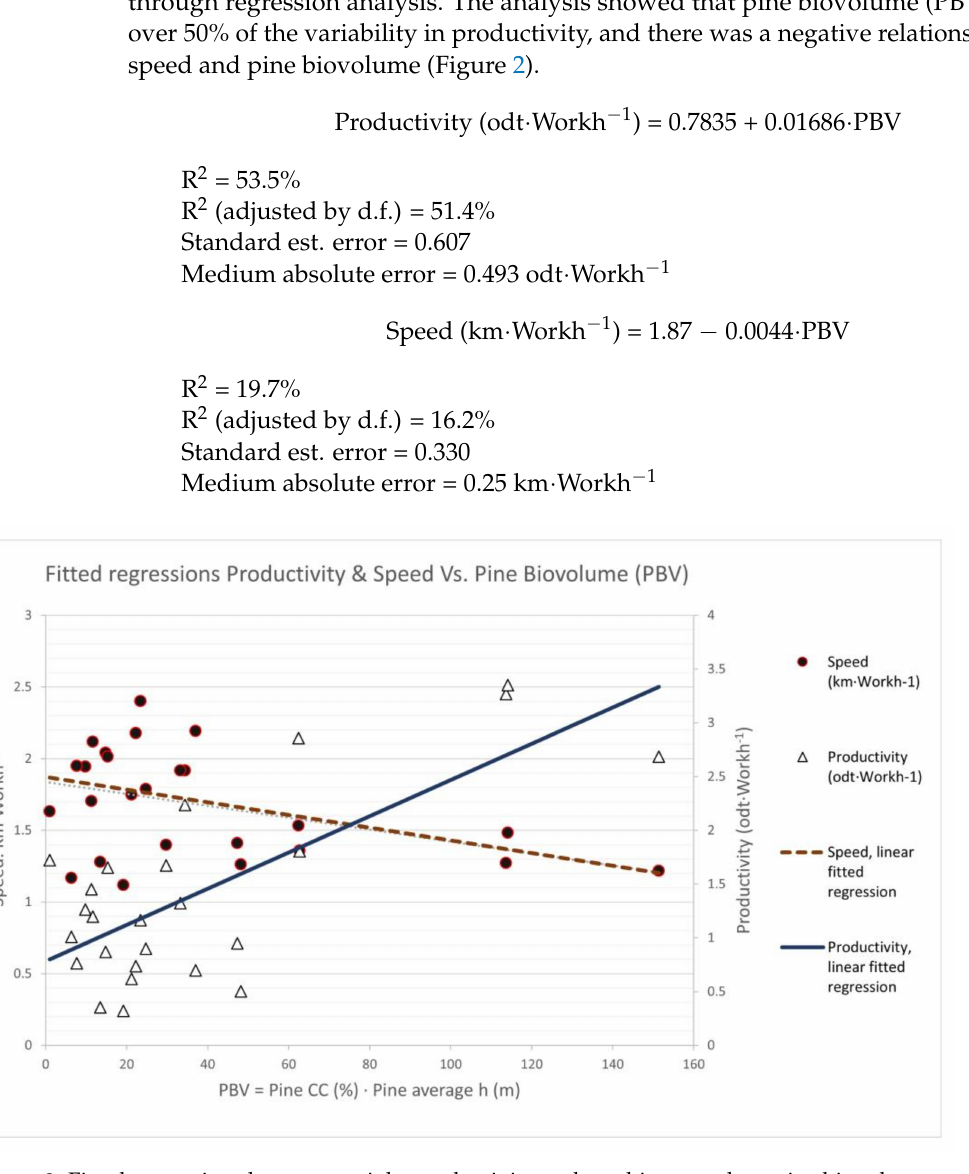
Figure 2. Fitted regressions between weight productivity and machine speed vs. pine